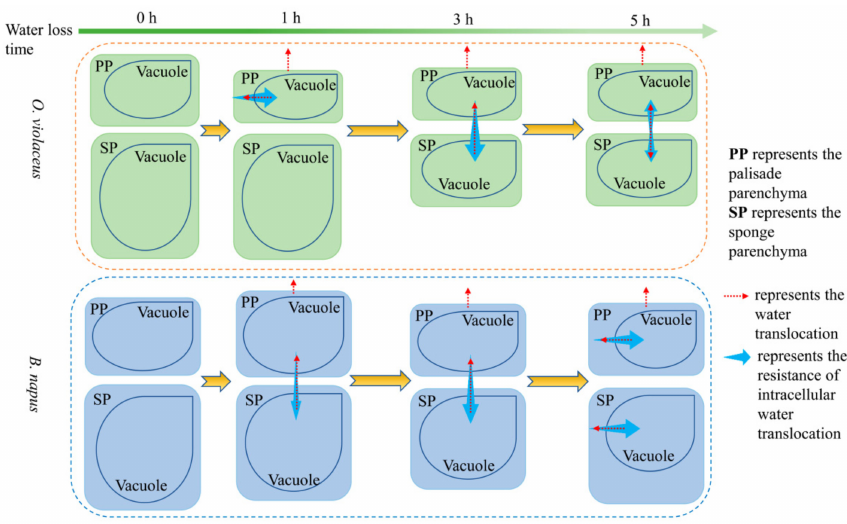
Figure 4. Leaf intracellular water translocation in O. violaceus and B. napus